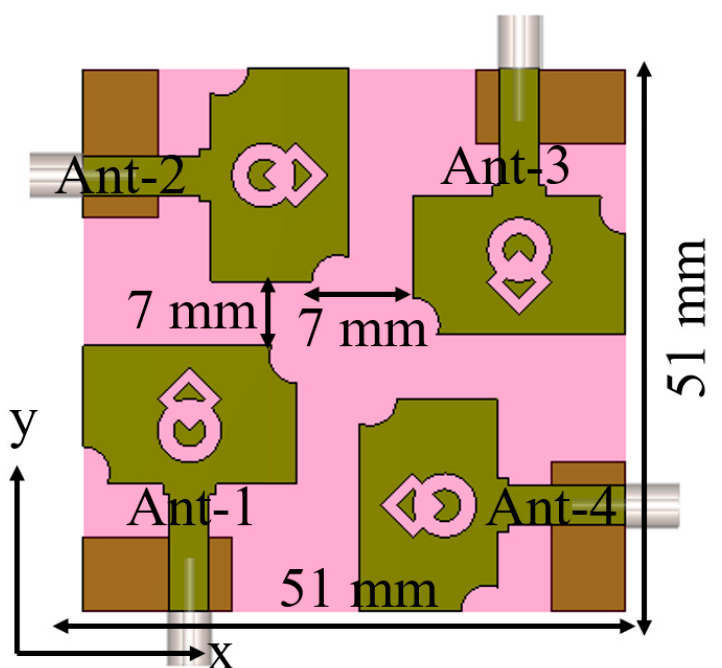
Figure 8. MIMO antenna design.